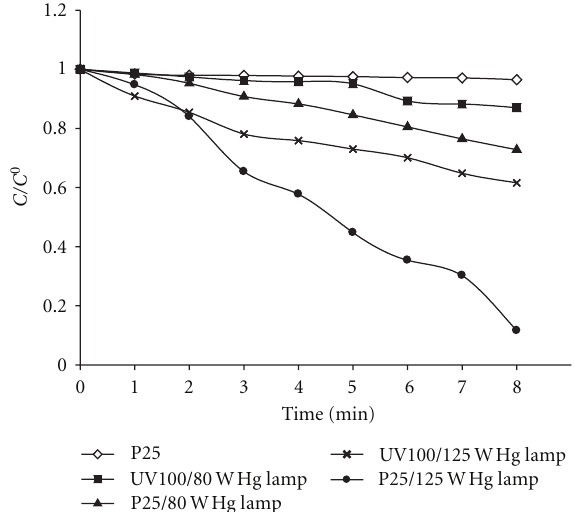
Figure 2: E ff ect of light intensity on degradation rate of Dinoseb. Experimental conditions: light intensity 80 and 125W.